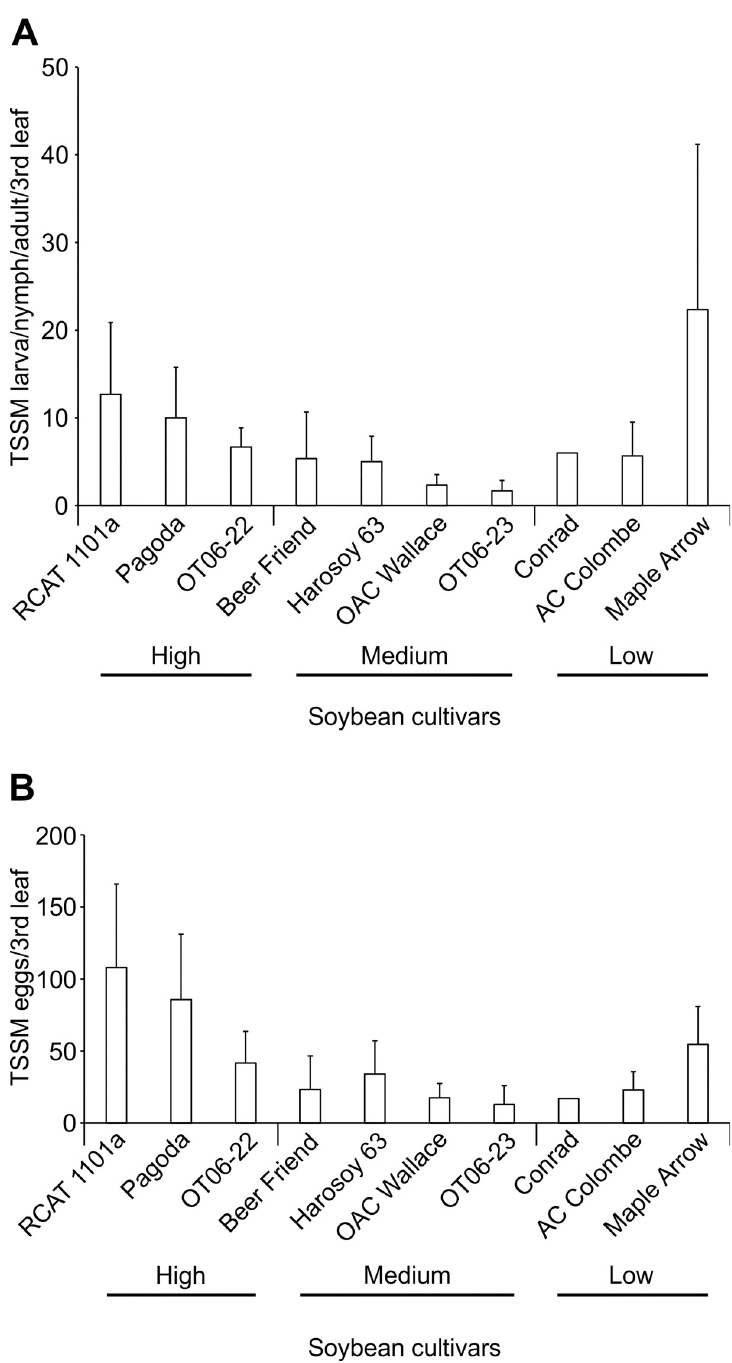
Fig 2. The performance of two-spotted spider mite on the 2 nd and 3 rd full leaf of 10 soybean cultivars after 10 days feeding. Data are the mean ( ± S.E.) TSSM larvae, nymph, adult and egg counts. No significant difference in TSSM larva, nymph and adult (Kruskal-Wallis, P > 0.05) or TSSM egg (Kruskal-Wallis, P > 0.05) numbers was revealed between the different cultivars tested beginning at the V3 stage.